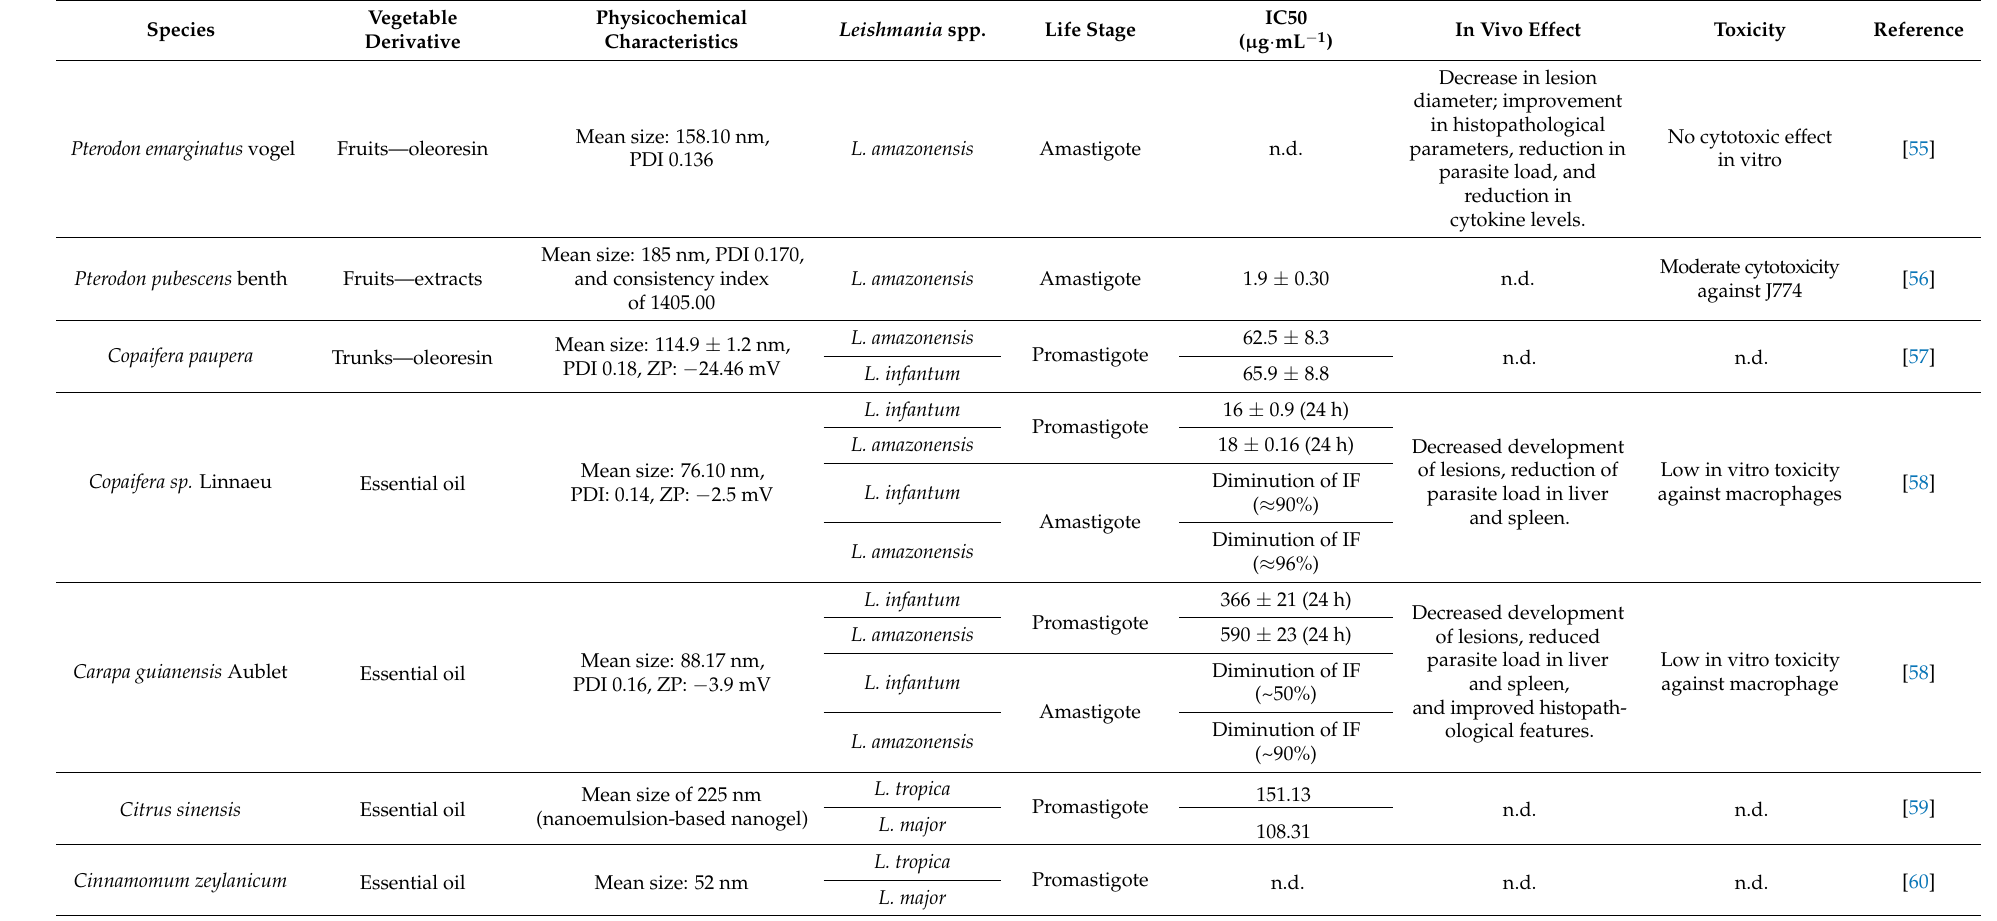
Table 1. Relationship of plant-based nanoemulsions as leishmanicidal